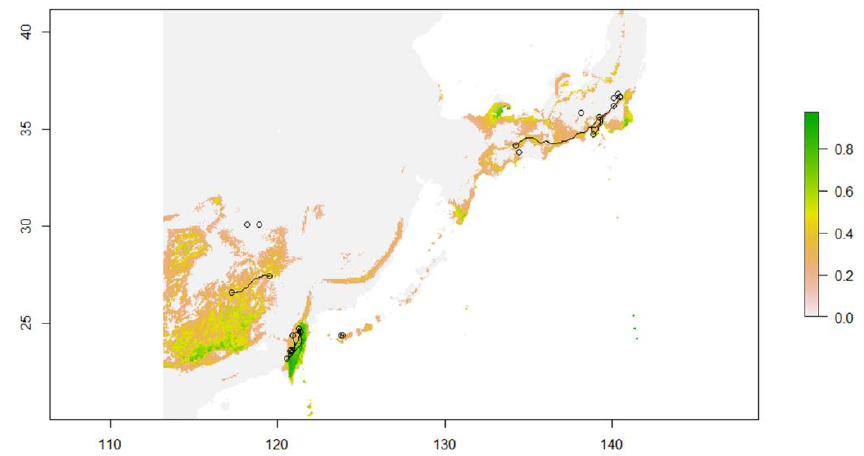
Figure 8. Modeled potential suitable habitat range and least-cost path of C. ramondioides during the last glacial maximum (LGM). Gray: land configuration during the LGM. Hollow circles: populations sampled during this study. Color bar: green to white denotes suitable to unsuitable habitat for Conandron during the LGM.